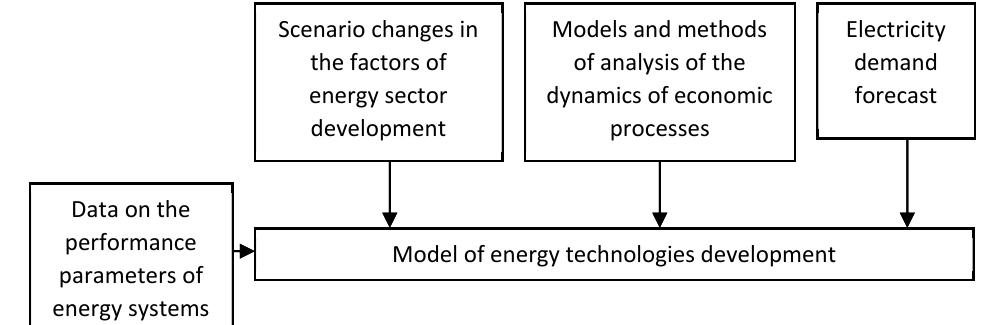
Fig. 1: Components of the process of model‐scenario analysis of the development of energy technologies